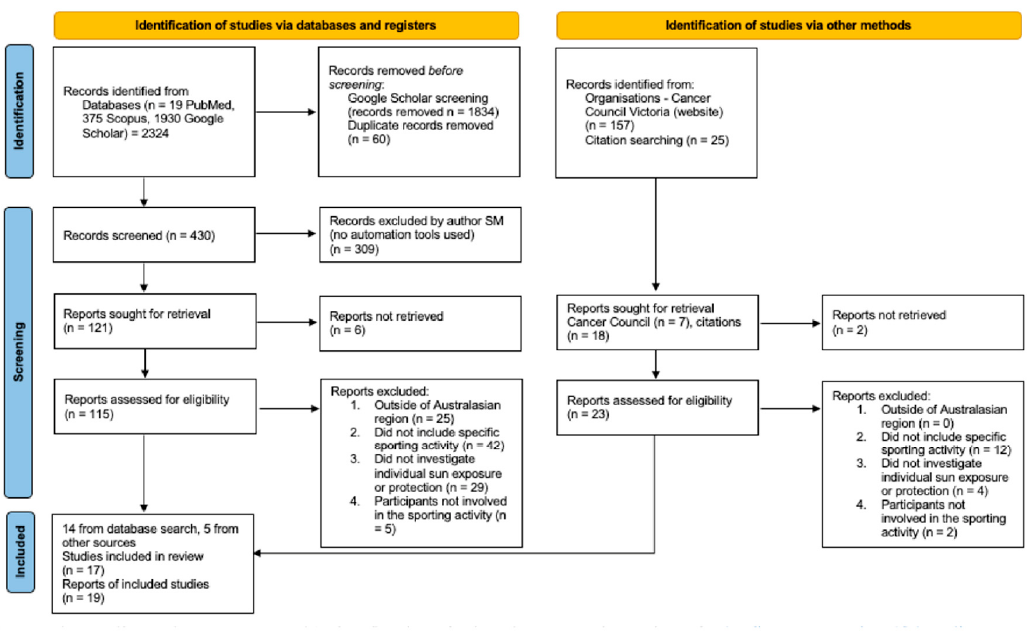
Figure 2. Extended PRISMA Flowchart for Search Strategy [26].